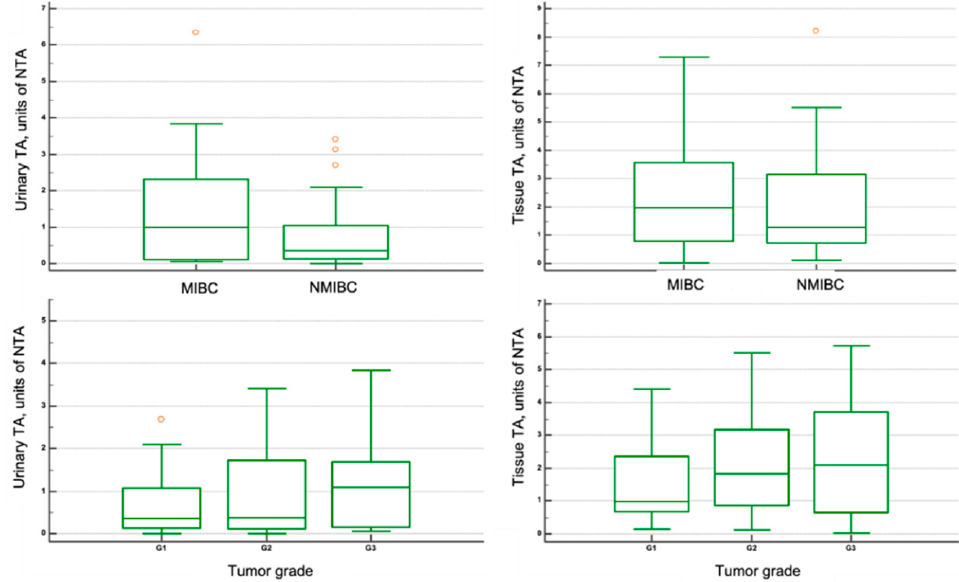
Figure 3. Boxplots showing the urinary and tissue Telomerase activity (TA) levels in BCa patients with different tumor stages and grades. NTA: normalized telomerase activity; NMIBC, non-muscle- invasive bladder cancer; MIBC, muscle-invasive bladder cancer.